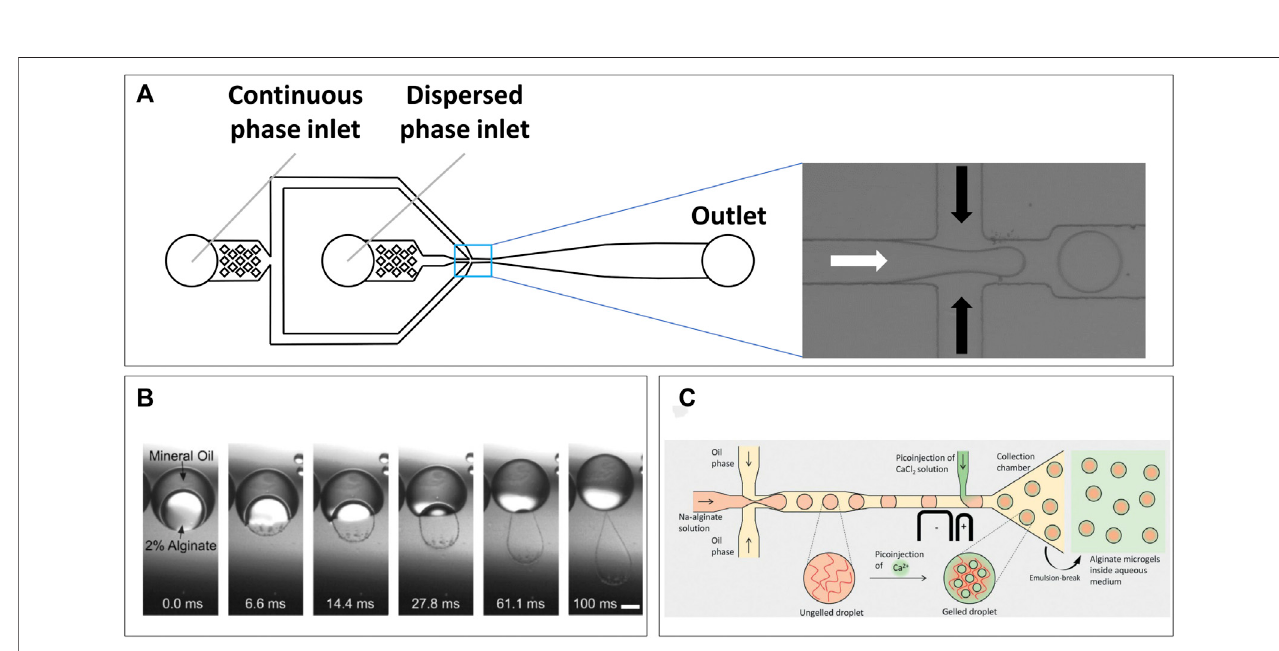
FIGURE2 | Micro fl uidicdropletformation. (A) Genericemulsi fi cationdevice,twoinletsforthecontinuousanddispersedphaseswhichmixatthechannelintersection(pop- out),dropletsthencontinue fl owingtoward collection fromoutlet. (B) Transferofalginatesolutionfromadouble-emulsiontoward aCaCl 2 solutioncausesgelationwithin 100 ms (Martinez et al., 2012). (C) Micro fl uidic design utilizing pico-injection of CaCl 2 after droplet formation point to prevent premature gelation of alginate solution (Ahmed et al., 2021).